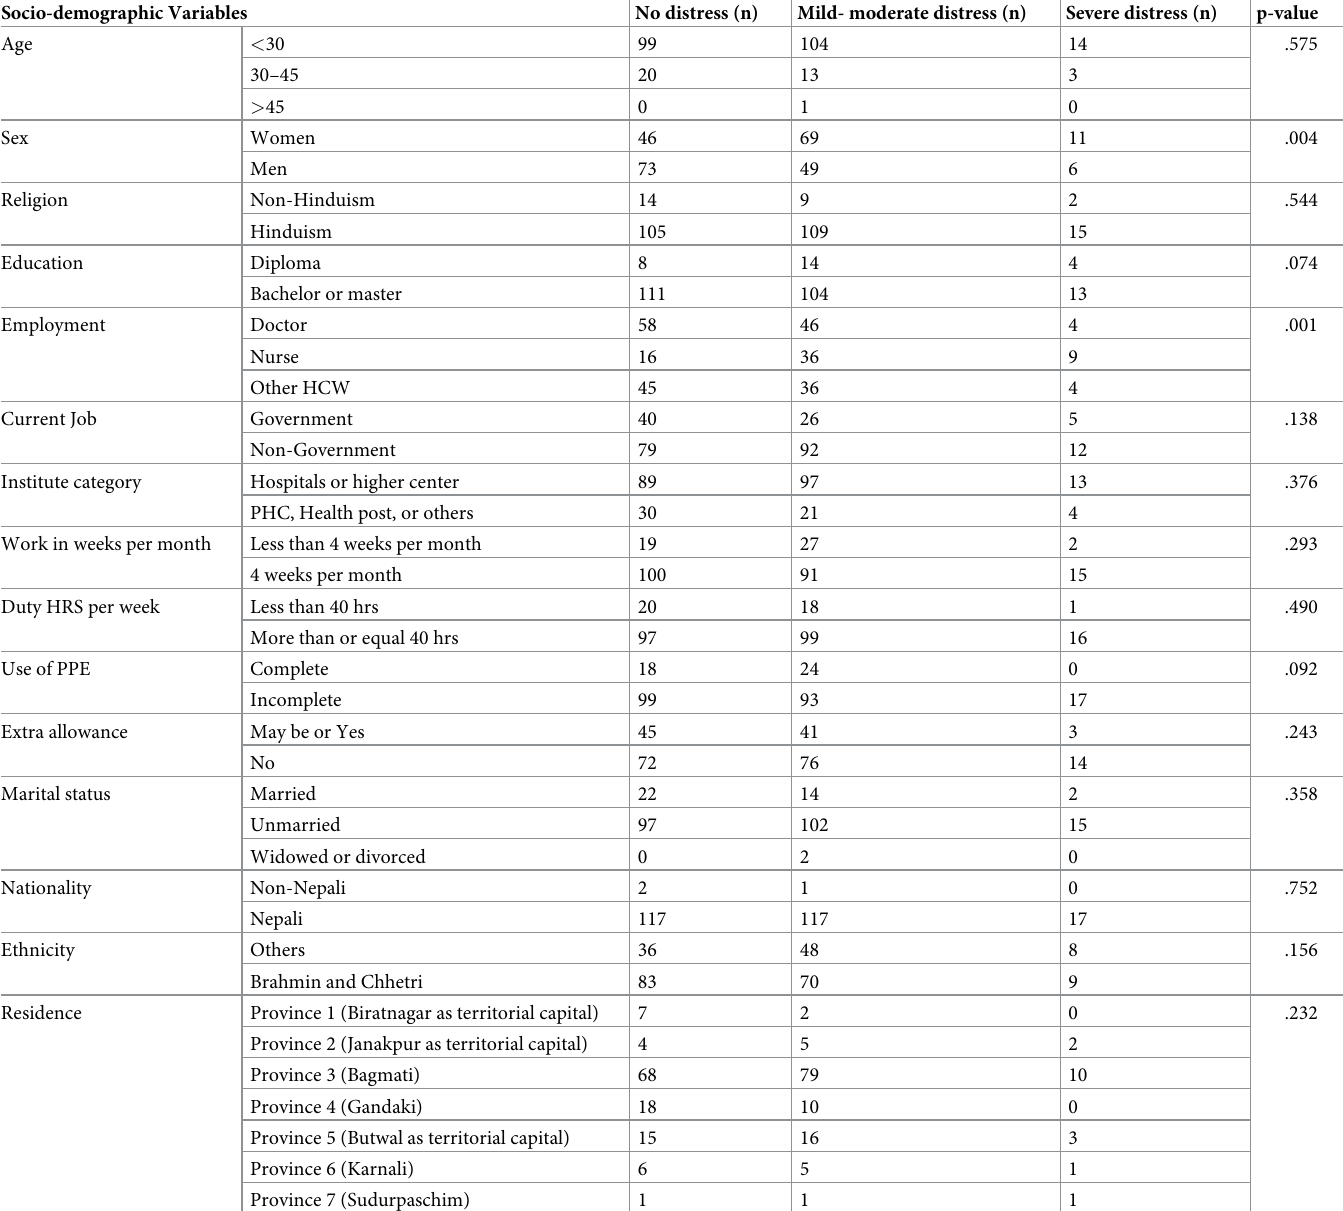
Table 3. Prevalence of CPDI by socioeconomic and demographic characteristics among HCWs in Nepal. Socio-demographic